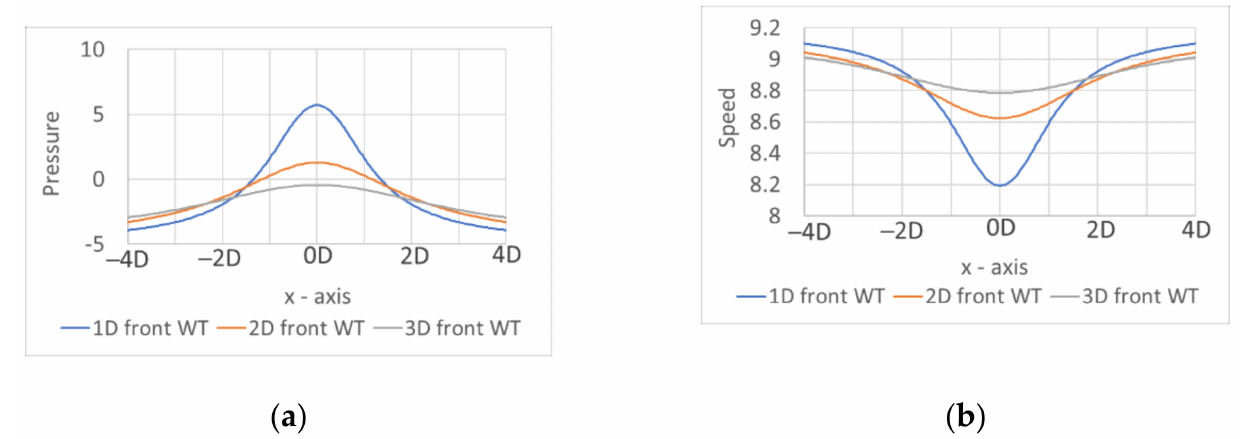
Figure 14. Induction zone of only one turbine: ( a ) static pressure; ( b ) speed.